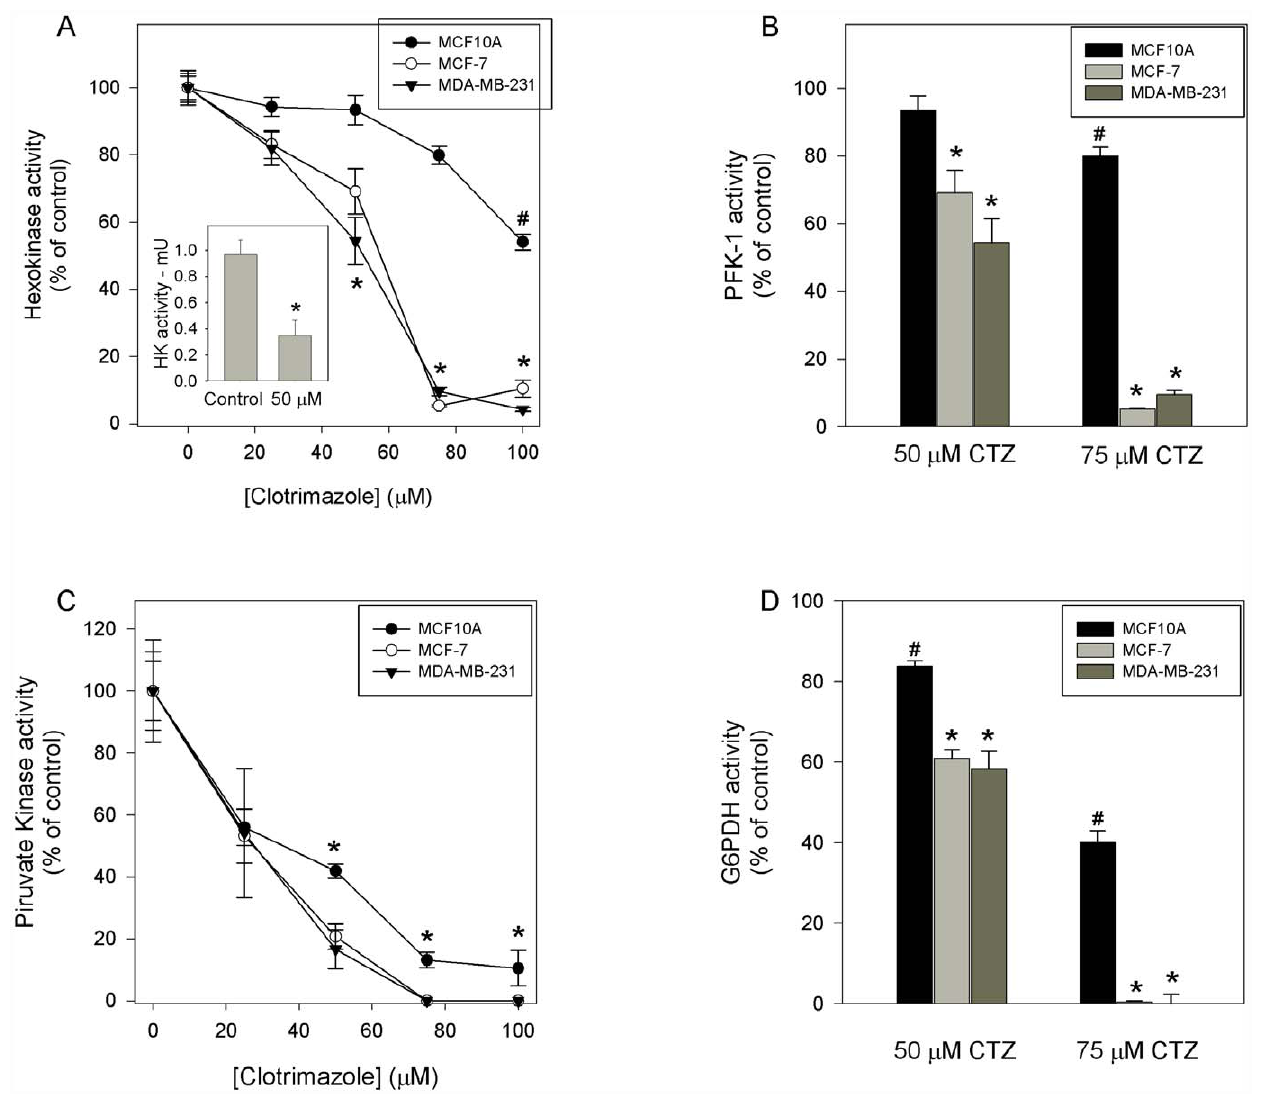
Figure 4. Glycolytic enzymes activity and G6PDH activity are inhibited by clotrimazole. Cell lines were grown to confluence in the indicated media as described in Methods. Cell lysates were used to evaluate HK, PFK-1, PK and G6PDH activities (panel A, B, C and D respectively) as described in Methods. Plotted values are mean 6 standard errors of five independent experiments. (A) # P , 0.05 compared to control in the absence of clotrimazole; * P , 0.05, compared to control in the absence of clotrimazole. (B) # P , 0.05 compared to control in the absence of clotrimazole; * P , 0.05, compared to control and to MCF10A in the presence of clotrimazole. (C) The differences among the results obtained with the distinct clotrimazole concentrations tested are statistically significant. * indicate differences between MCF10A and tumoral breast cell lines. (D) # P , 0.05 compared to control in the absence of clotrimazole; * P , 0.05, compared to control and to MCF10A in the presence of clotrimazole.